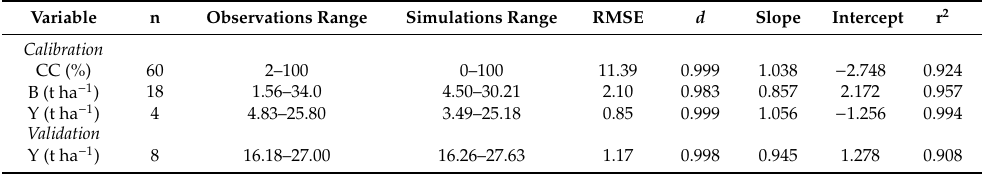
1 Top soil thickness considered for the estimation of soil water depletion (Program settings: Crop parameters). -: Information is not available. Table 3. Statistics (root mean square error–RMSE- and index of agreement– d -) for the comparisons between observed and simulated values of green canopy cover (CC), total dry biomass (B), and root dry yield (Y) for the calibration and validation of the AquaCrop model. Slope, intercept, and r 2 are for the linear regression of observed against simulated values. n is the number of observed data used in the calibration and validation